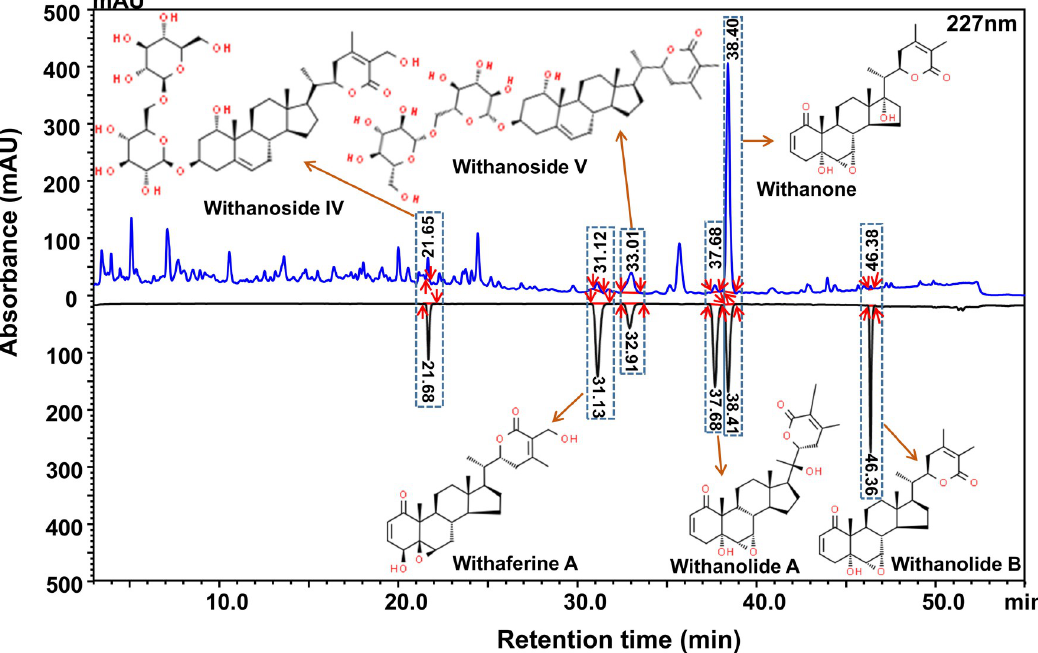
Fig 7. Phytochemical compositional analysis of WSWE. Overlap HPLC chromatograms of standard mix (black) and WSWE (blue) recorded at 227 nm. Identified phytocompound peaks are indicated with orange arrows pointing towards respective chemical